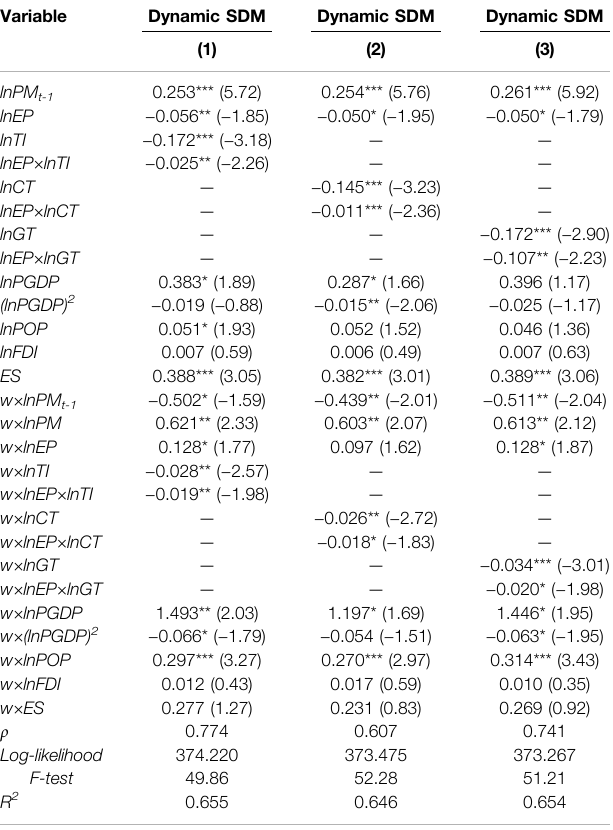
TABLE 8 | Moderating effect of environmental